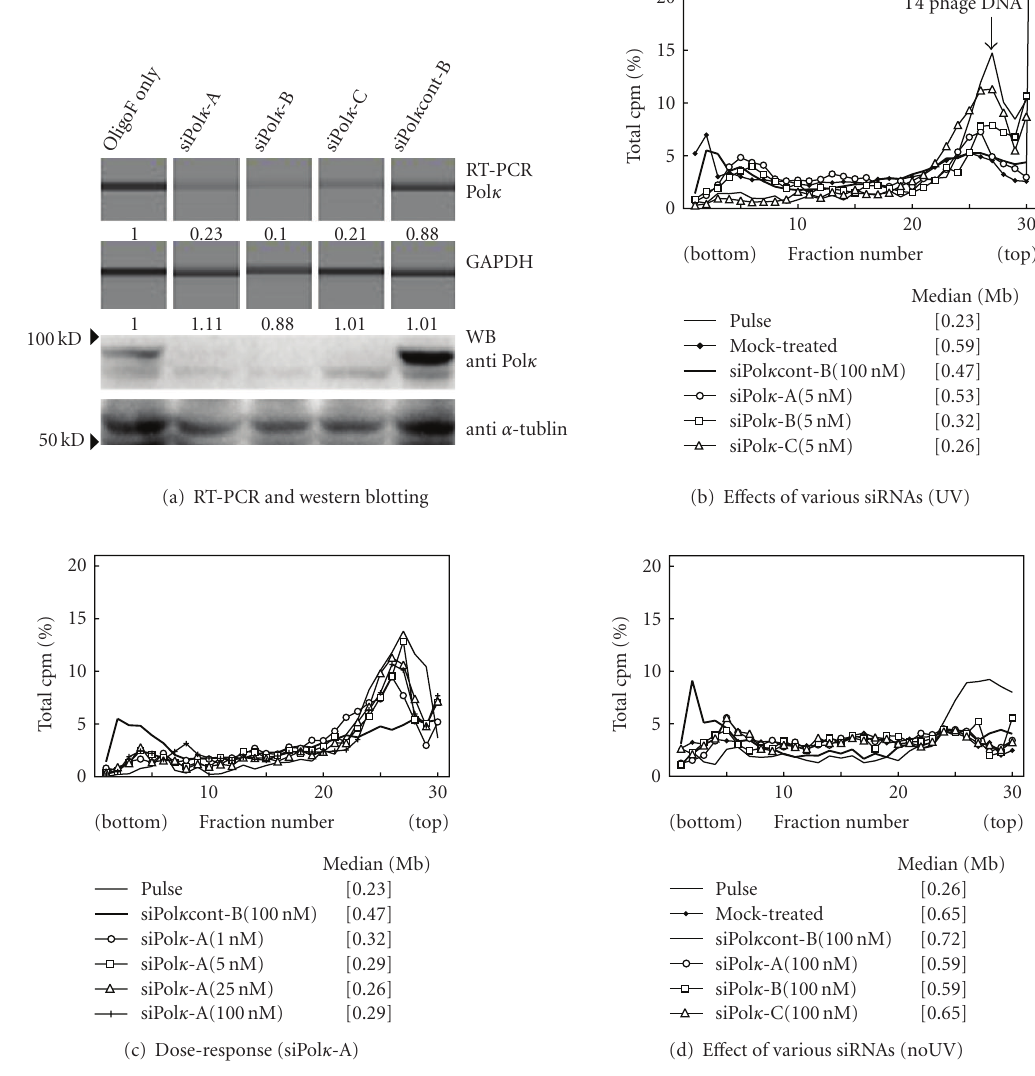
Figure 6: E ffi cient knockdown by Pol κ siRNAs and the e ff ects on UV-induced TLS in HeLa cells (ASDG profiles of replication products). (a) E ffi ciency of knockdown on Pol κ expression (RT-PCR analysis and western blot analysis), (b) E ff ects of various Pol κ siRNAs on UV- TLS, (c) Dose-response of siPol κ -A on UV-TLS, (d) E ff ect of various Pol κ siRNAs (no UV control). Twenty-four hours after Pol κ siRNA transfection, total RNA was isolated and Pol κ RNA was quantified by RT-PCR. Results were shown in MultiNA gel images and the expression level was presented under the panel (a). Forty hours after Pol κ siRNA transfection, whole cell extracts were prepared, and Pol κ protein was quantified by western blot analysis (a). Forty hours after Pol κ siRNA transfection, cells were UV-irradiated (10J/m 2 ), incubated in normal medium for 30 minutes, pulse-labelled with 10 μ Ci/mL of [ 14 C]thymidine for 1 hour, then washed twice with PBS, and incubated for 5 hours at 37 ◦ C in normal medium (b, c). Forty hours after Pol κ siRNA transfection, cells were not UV-irradiated, pulse-labelled with 10 μ Ci/mL of [ 14 C]thymidine for 30 minutes, washed twice with PBS, and incubated at 37 ◦ C in normal medium for 1 hour (d). Some of these profiles overlap (c, d). Sedimentation is from right to left. The arrow indicates the position of T4 phage DNA (166kb, i.e.,